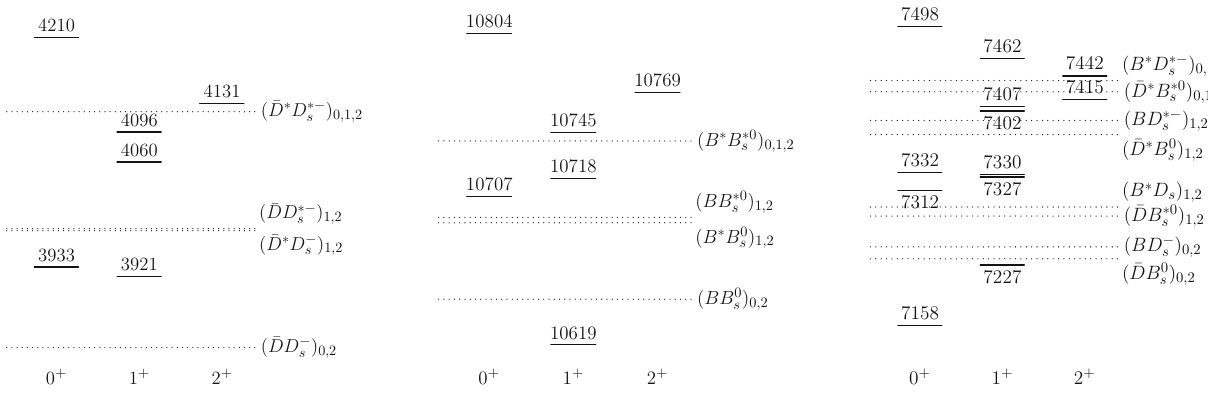
of a tetraquark is equal to a subscript of the symbol for a meson–meson channel, the corresponding S - or D -wave decay is allowed